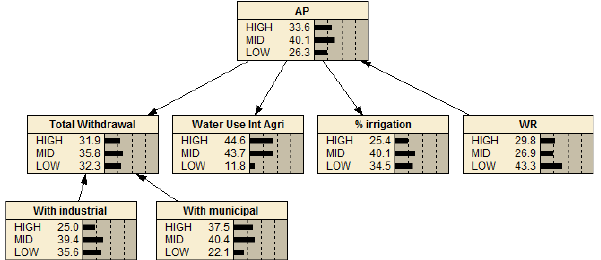
Fig. 6. DAG and initial probabilities for the variables involved in the AP pillar discretised in high (HIGH), medium (MID) and low (LOW)